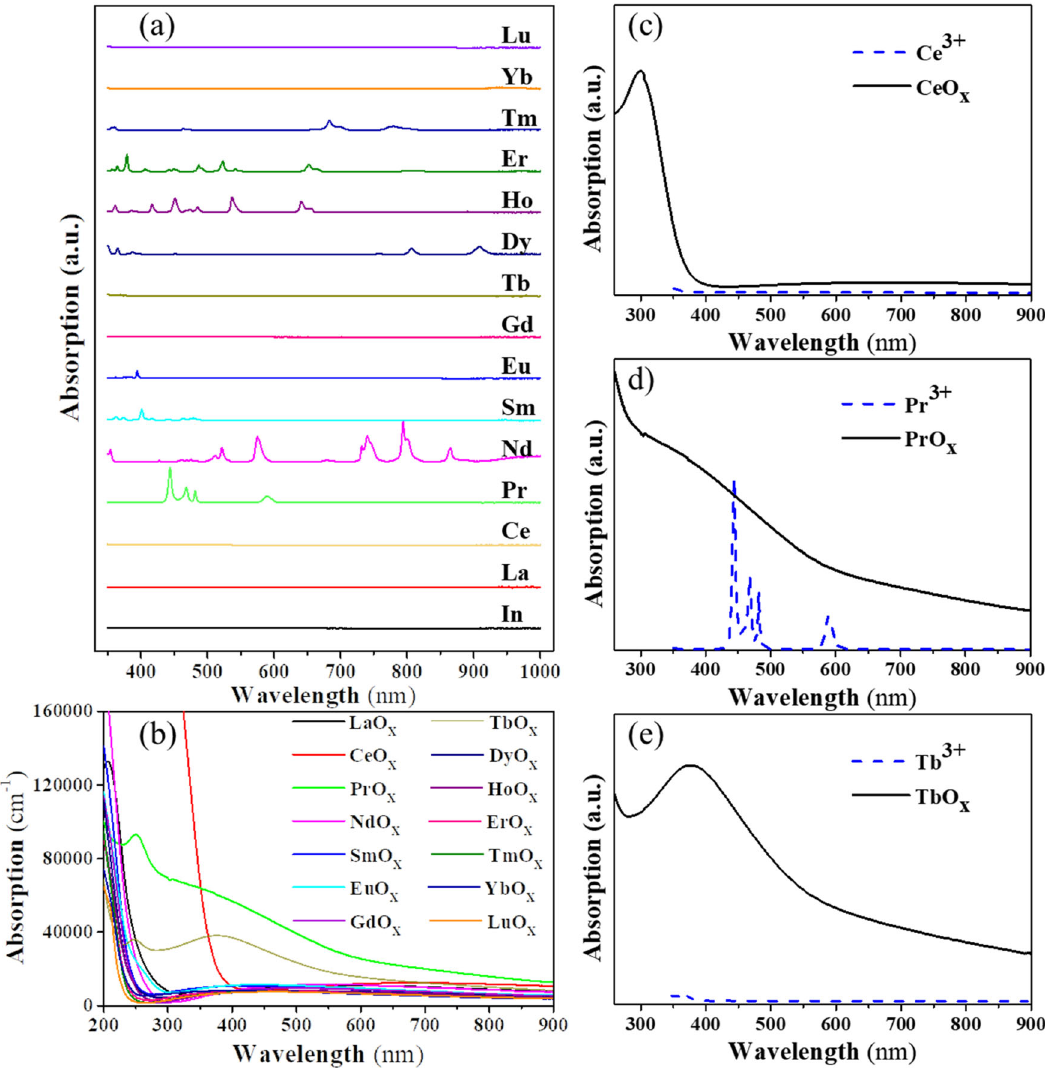
Fig. 2 The absorption of Ln(NO) 3 ·nH 2 O aqueous solutions and LnO x fi lms. a the absorption spectra of the different Ln(NO) 3 ·nH 2 O and In(NO) 3 ·nH 2 O aqueous solutions. b UV-visible light absorption of the different LnO x fi lms based on spin-coating Ln(NO) 3 ·nH 2 O aqueous solutions annealed at 300 °C. c – d UV-visible light absorption of c Ce 3 + and CeO x , ( d ) Pr 3 + and PrO x , and ( e ) Tb 3 + and TbO x